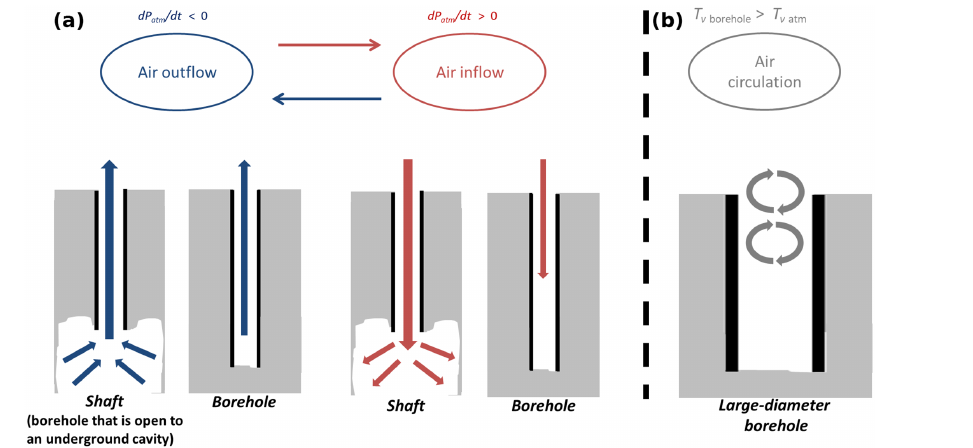
Figure 8. Conceptual model for airflow inside boreholes and shafts. Panel (a) represents the shaft–borehole and panel (b) represents the large- diameter borehole. Blue arrows illustrate the air outflow events in which air flows from the bottom cavity (shaft) or the bottom borehole–soil interface (borehole) to the atmosphere, whereas red arrows illustrate the air inflow events in the opposite direction. For example, as the red arrows indicate, air from the atmosphere will enter the cavity, equalling the absolute humidity (AH) values throughout the shaft to the atmospheric values. In contrast, in the borehole, this stage will only be effective to a certain depth and the bottom borehole–soil interface will not be significantly affected. In the large-diameter borehole, gray arrows illustrate the circulation of air from the atmosphere into the large-diameter borehole due to the thermal instability that initiates DIC. The diameter will define which advective transport mechanism is more significant: at a small diameter of 0.1m, BP controls gas transport (a) , whereas at a larger diameter of 3.4m, DIC is the dominant mechanism (b)